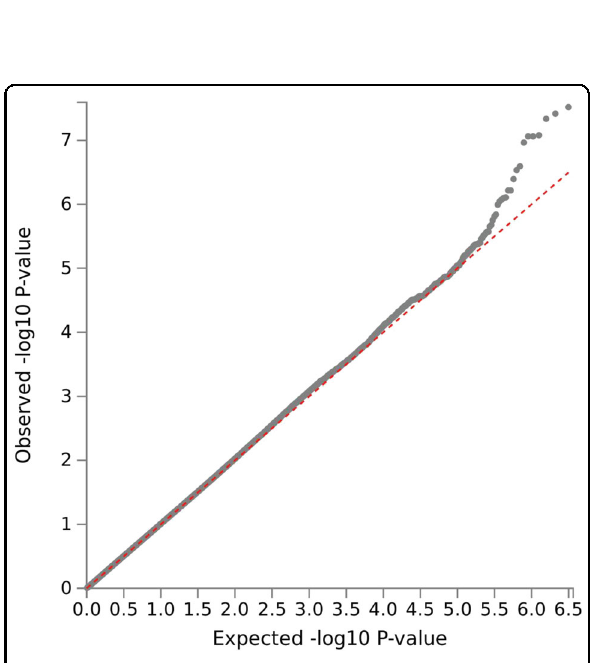
Fig. 2 QQ plot for meta-analysis of STCRP, CATIE-EUR, and CATIE- AFR. Note: Lambda =